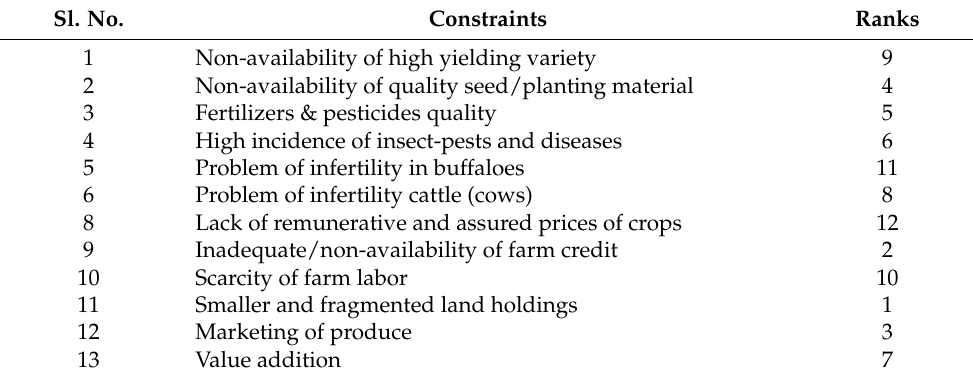
Table 4. Biophysical and socioeconomic constraints affecting climate change